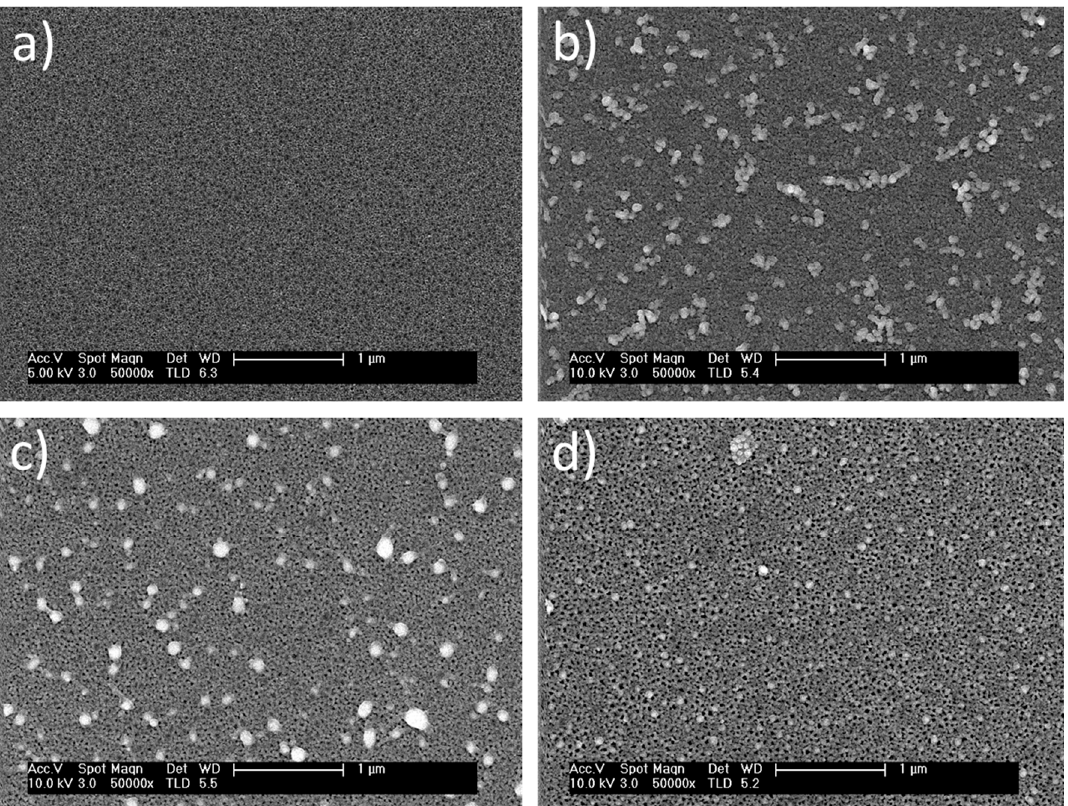
Figure 3. FESEM top-view images of a typical nanostructured PSi and hybrid PSi + AgNPs layers: ( a ) PSi top-view image (40 s etching time), ( b ) hybrid PSi + AgNPs top-view image (18 s etching time), ( c ) hybrid PSi + AgNPs top-view image (28 s etching time), and ( d ) hybrid PSi + AgNPs top-view image (40 s etching time). PSi etching current density of 60 mA/cm 2 and AgNPs infiltration conditions are constant.